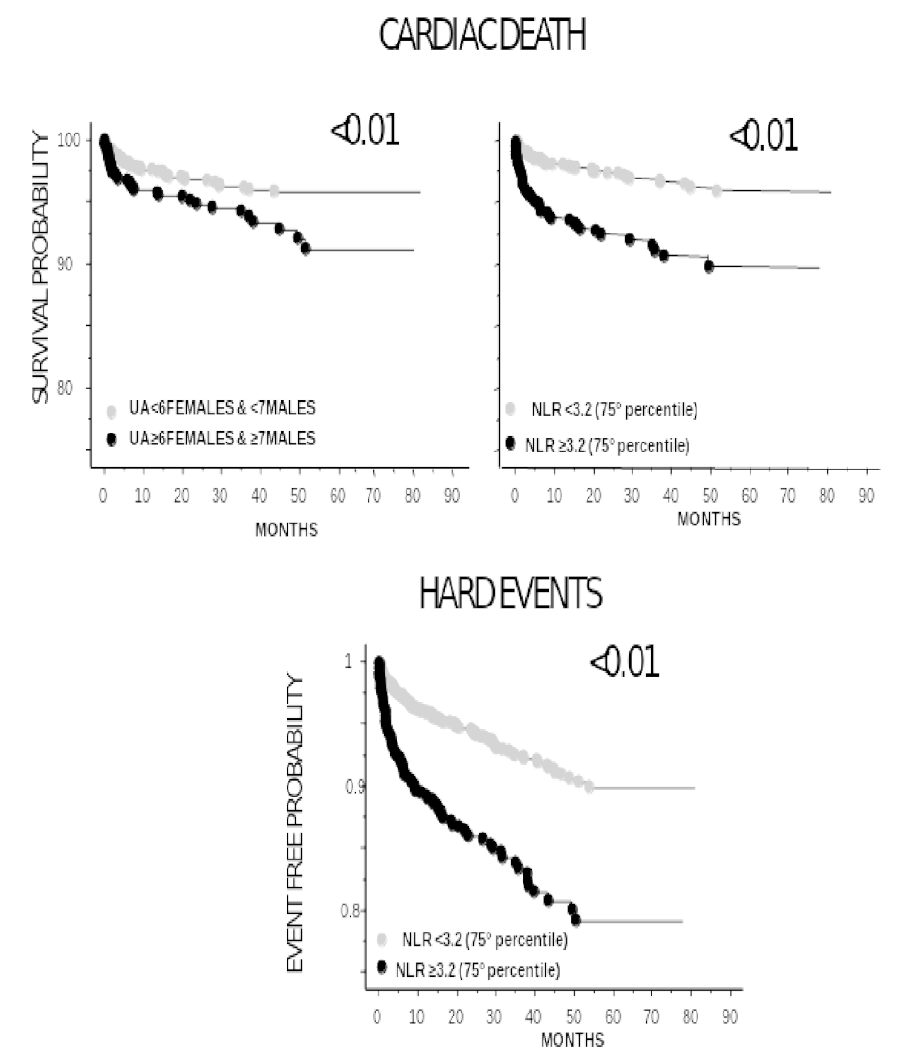
Figure 1. Kaplan–Meier survival curves according to UA and NLR levels for cardiac death and hard events (death plus reinfarction) as